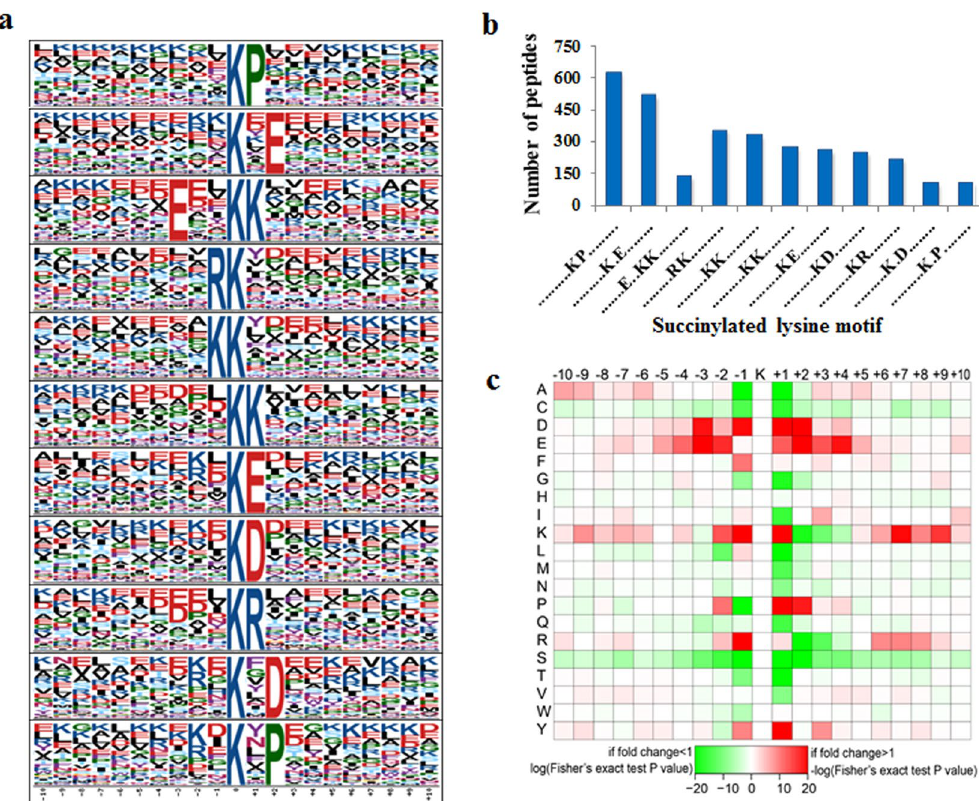
Figure 4. Motif-X analysis of the amino acids ( ± 10) surrounding the identified succinylated residues. ( a ) Sequence logo representation of 10 conserved succinylation motifs. ( b ) The number of identified peptides possessing a succinylated lysine within each motif. ( c ) A plot showing the relative abundance of amino acids flanking a succinylated lysine, which is shown using the intensity